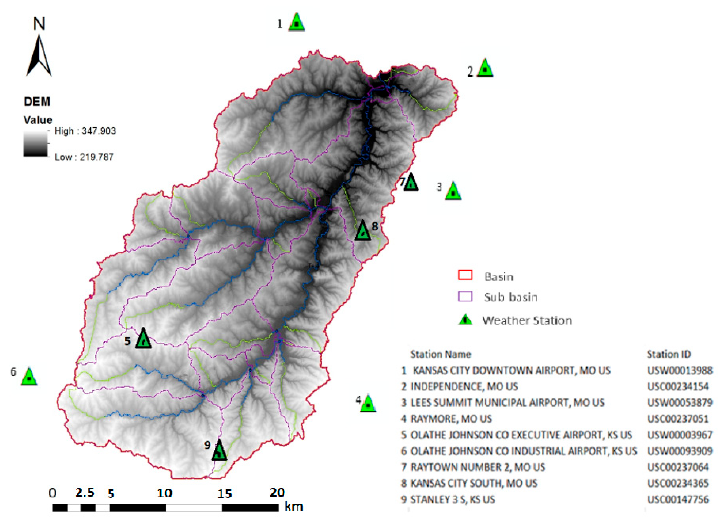
Figure 3. Delineation of Blue River Watershed and location of NOAA weather stations.